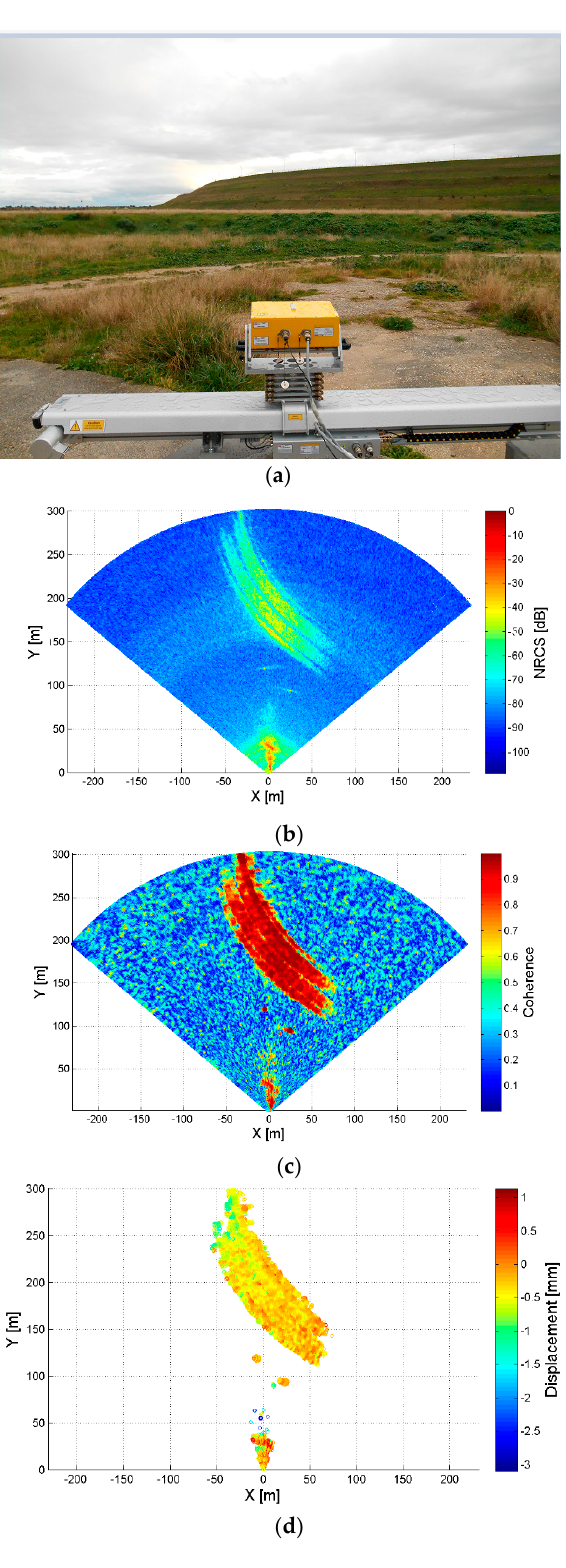
Figure 9. Marana-Capacciotti dam, Cerignola. Amplitude of the horizontal displacement map represented over the dam surface.